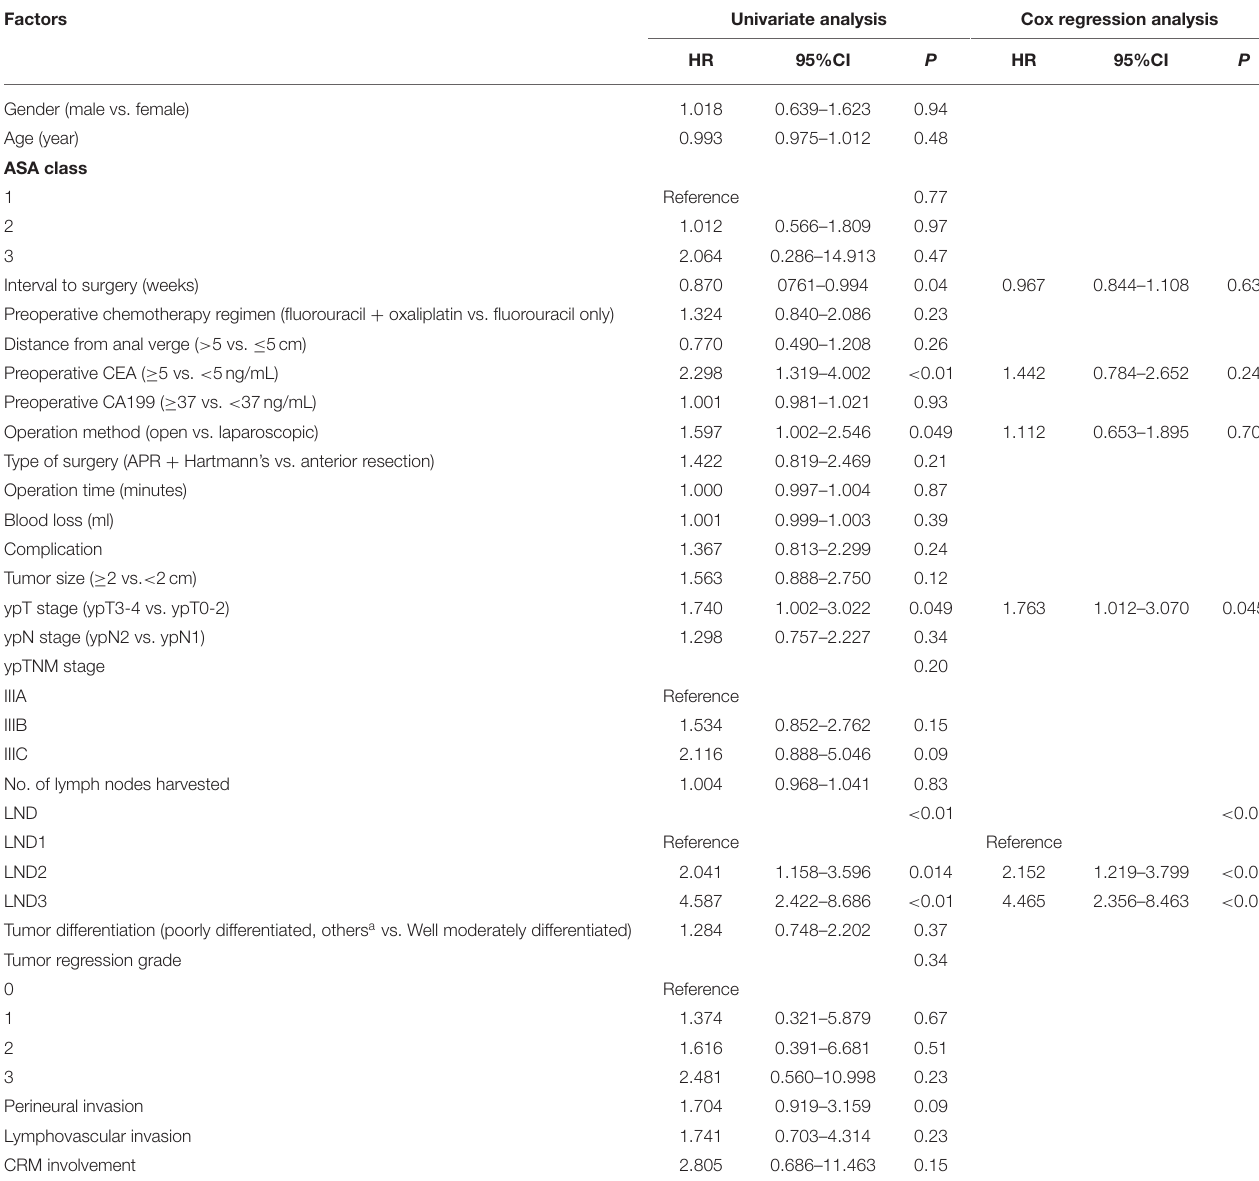
TABLE 2 | Cox regression analysis of factors for 3-year disease-free survival in ypN + rectal cancer patients after nCRT. Factors Univariate analysis Cox regression